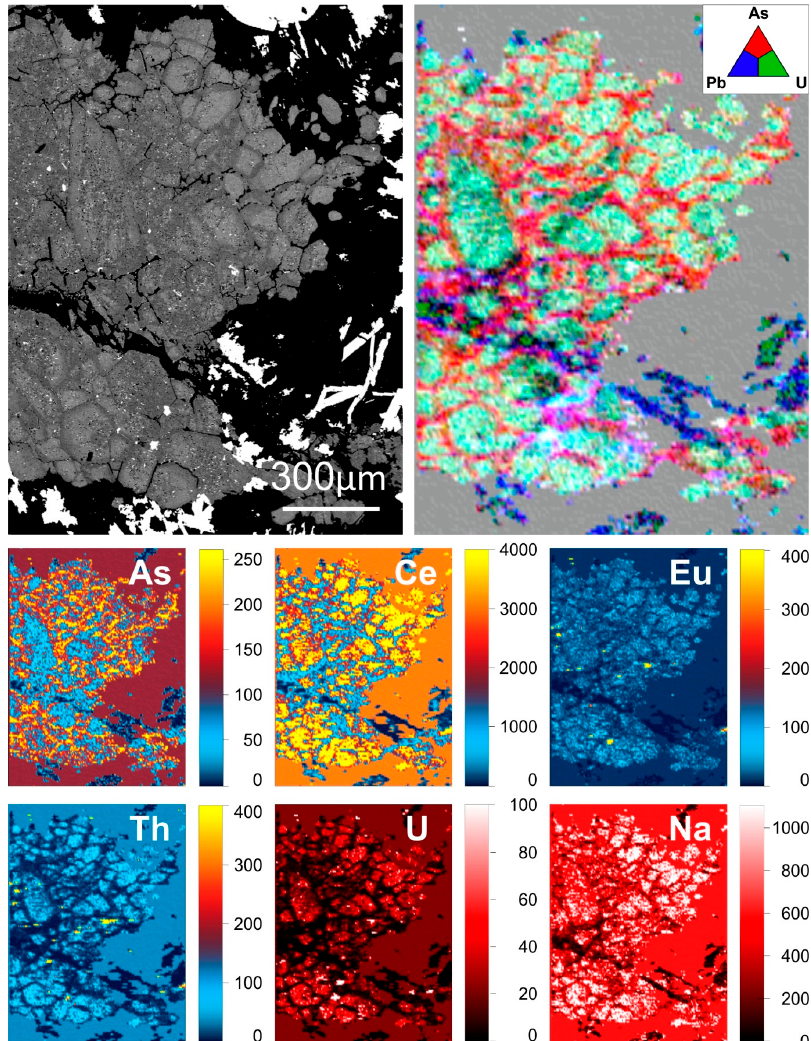
Figure 8. LA-ICP-MS map of a large aggregate of apatite grains (sample 2773-3, Figure 1, Table 1) displaying core-to-rim- and fracture-related zoning consisting of cores rich in REY and REY-depleted rims and fractures. Note relative enrichment of As along grain rims and attributed to crystallization from more oxidized fluids that the core. All scales are in ppm.